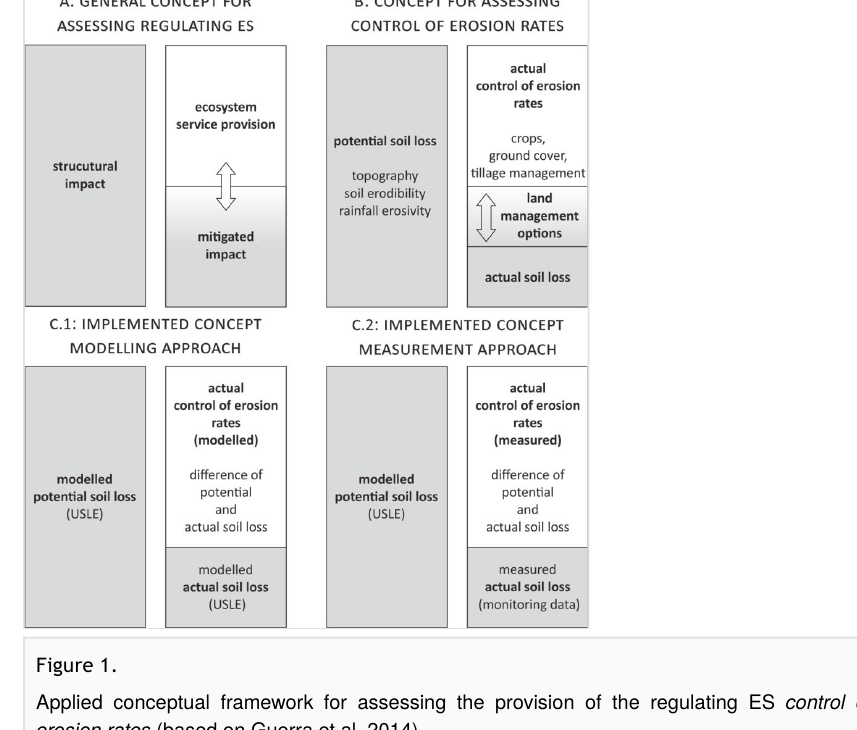
Applied conceptual framework for assessing the provision of the regulating ES control of erosion rates (based on Guerra et al.